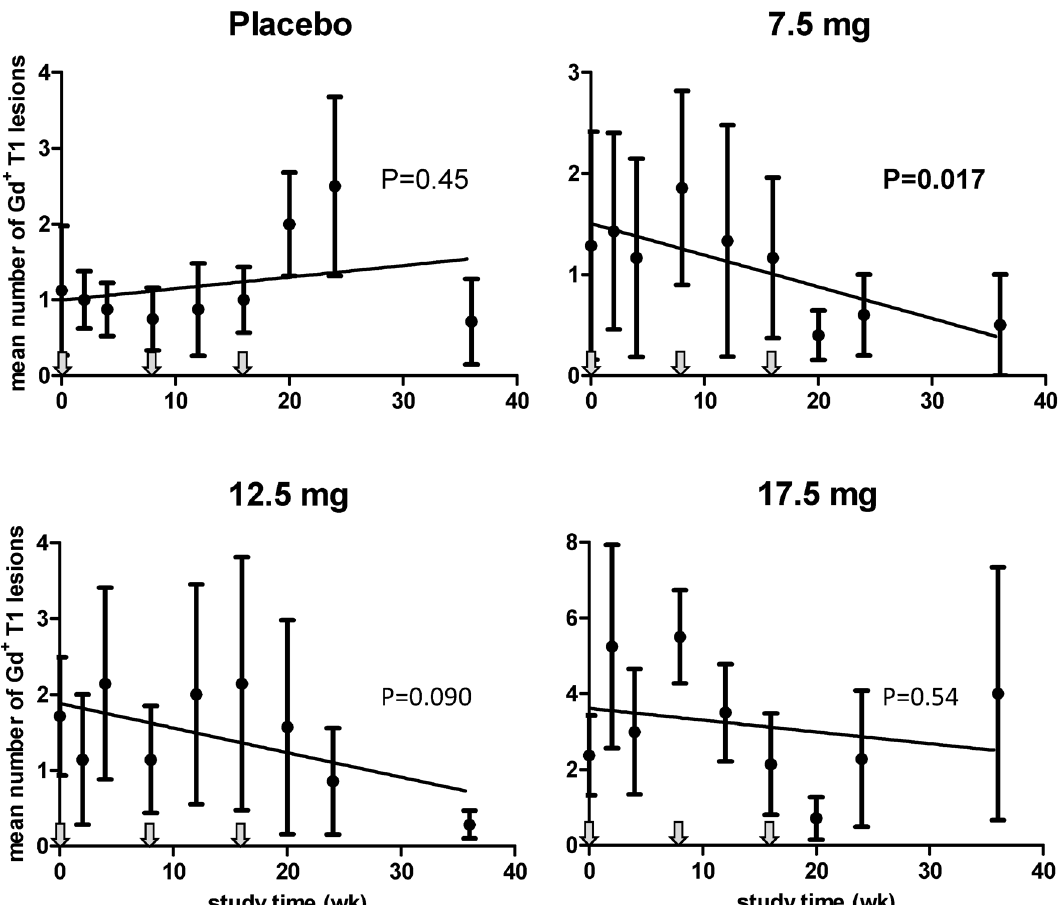
Fig 4. The impact of intravenous HspB5 on active MRI lesions in RR-MS patients. RR-MS patients received three bimonthly intravenous administrations of either PBS as placebo, or HspB5 at the indicated doses, and mean numbers of Gd + T1 lesions for each group were evaluated by MRI over 36 weeks. Fig 4 shows mean values ± standard deviation, as calculated for the full analysis set of patients, including readings for 7 to 8 subjects at different time points for each group except for the 7.5-mg group, which included readings for 4 to 8 subjects. Linear regression analysis was used to evaluate the trends of change in each group over 36 weeks; p values reflect the probability that the deviation of such trends from a horizontal line is a chance event. Arrows indicate times of administration of placebo or